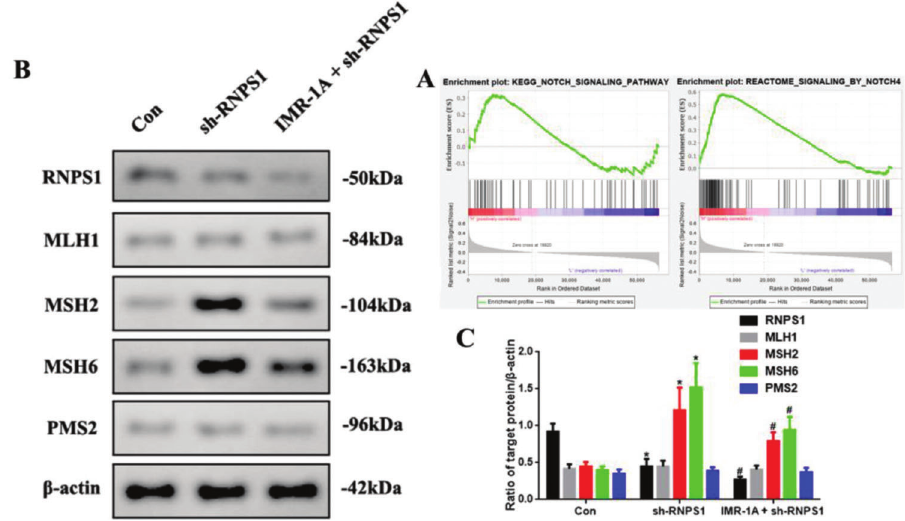
Figure 7 - (A) GSEA of the correlation between RNPS1 and Notch or Notch4 signaling pathway in UCEC. (B) Western blot assay for the analysis of the RNPS1, MSH1, MSH2, MSH6, and PMS2 expression levels in vivo . (B) Quantitation of RNPS1, MSH1, MSH2, MSH6, and PMS2 expression levels. (n=6, * p o 0.05: sh-RNPS1 vs. Con; # p o 0.05: IMR-1A + sh-RNPS1 vs.